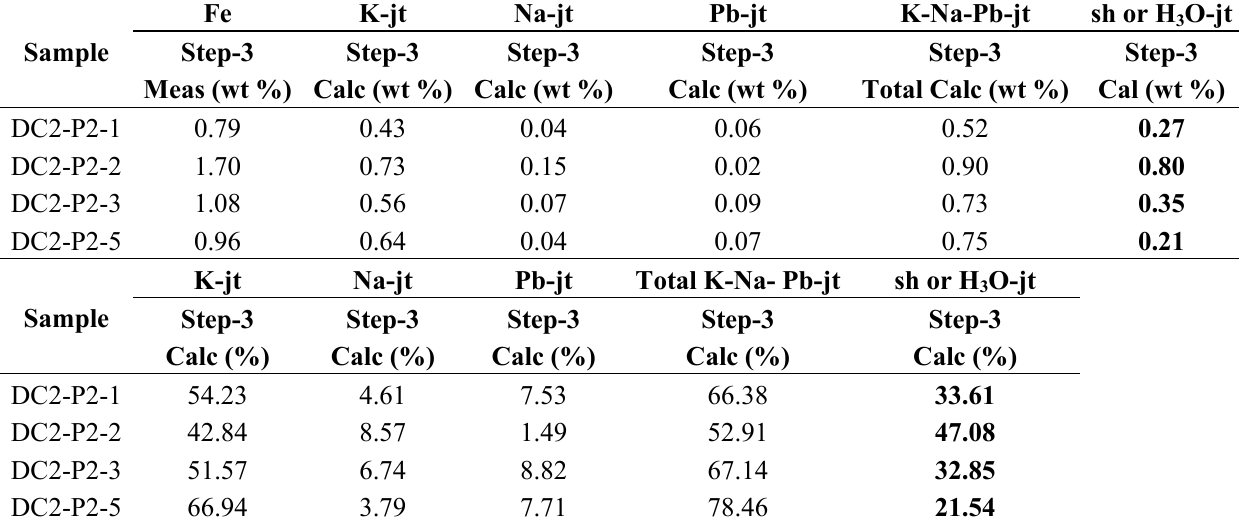
Table 1. Stoichiometric calculations (Calc) of Fe in K, Pb, and Na jarosites (jt) according to the measured (Meas) K, Pb, and Na in Step 3 from sequential extractions from